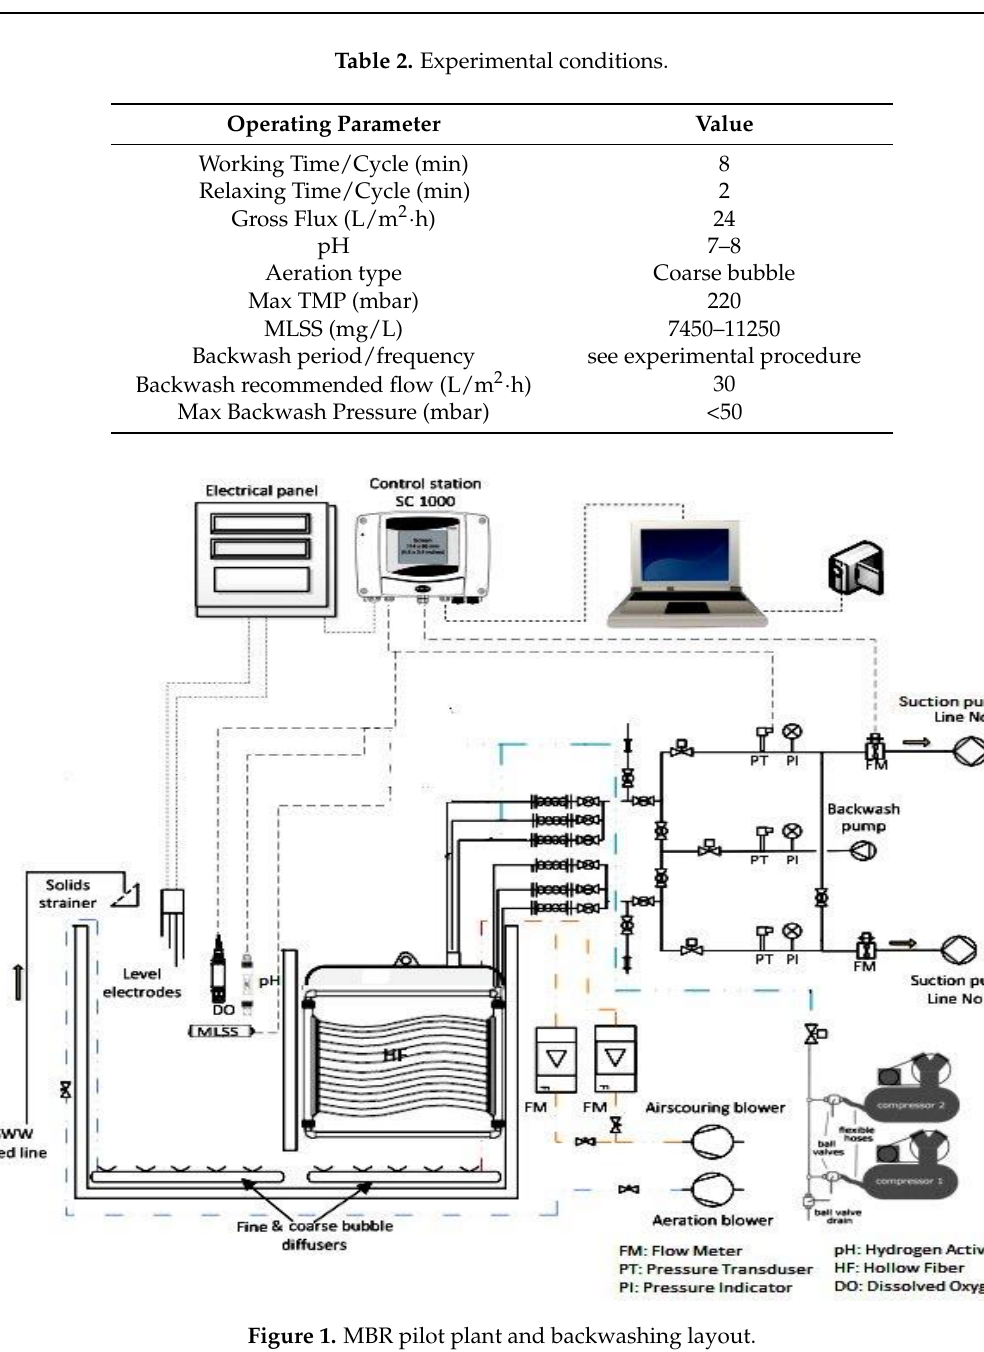
Figure 1. MBR pilot plant and backwashing layout.